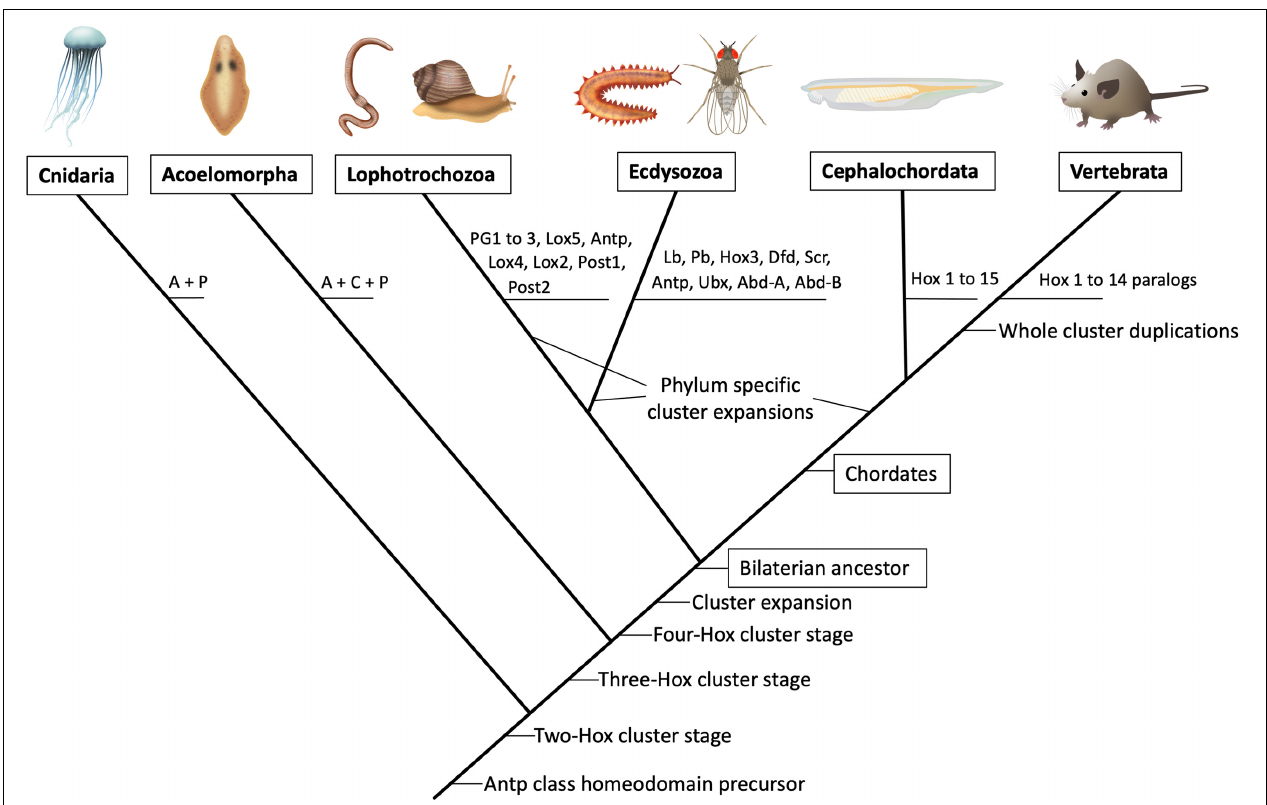
FIGURE 1 | Schematic phylogenetic tree showing the predicted evolution of the Hox paralogous groups. Illustrations of major extant animal groups are presented on top joined by their currently accepted branching points (not to temporal scale). The predicted appearance of particular Hox paralog gene precursors is depicted on the branching points. In the vertebrate lineage the whole cluster duplicated several times (not represented) giving rise to four paralogous Hox clusters named HoxA to HoxD in birds and mammals. In teleost fish a further duplication gave rise to eight Hox clusters. For a comprehensive analysis of Hox cluster evolution (see Figure 2A ). A, anterior; C, central; P,